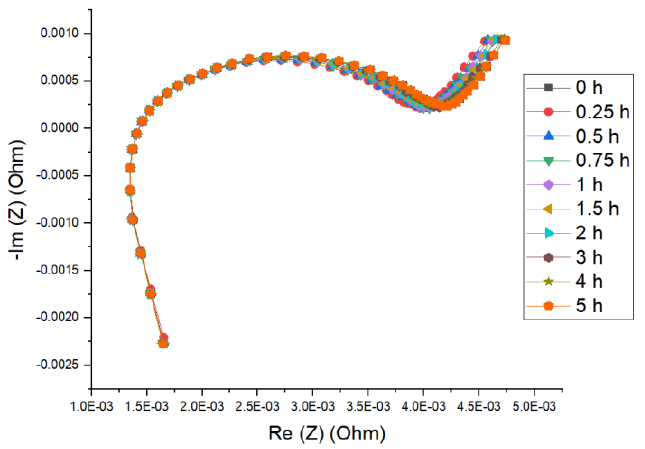
Figure 6. Nyquist plot for fresh NMC cell at various relaxation times (50% SoC at 15 °C).